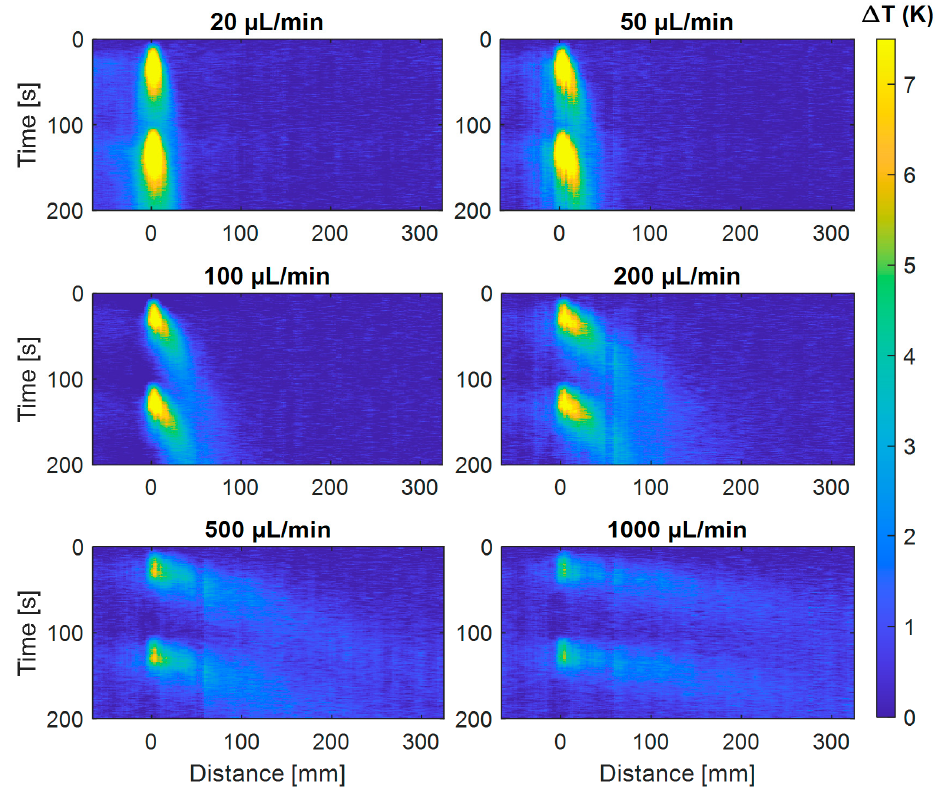
Figure 5. Propagation of the heating pulses induced in ethanol at a fixed fiber position (indicated at a distance of 0 mm) as a function of time and distance for different flow rates. Two heating pulses are injected during 30 s and separated by a 70 s waiting period. The convective heat transport by the flow is clearly observable for the different flows. The color bar indicates the measured temperature increase ∆𝑇 (in Kelvin) of the ethanol, which for low flow rates reaches up to ≈ 7 K above room temperature.